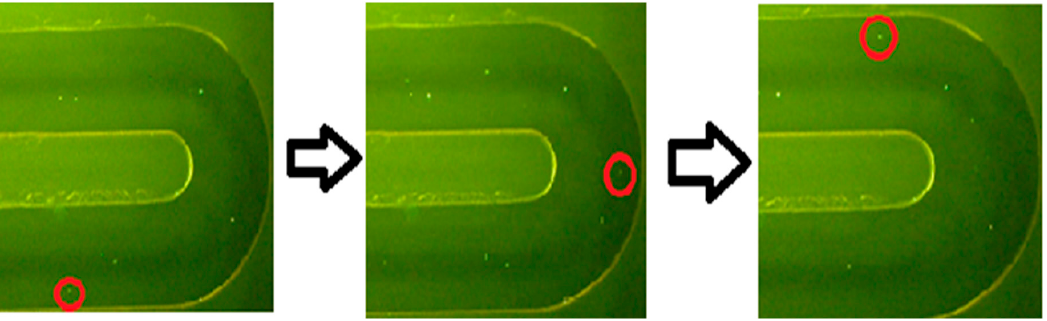
Figure 2. Detection of microsphere movement at 45 µL/min.